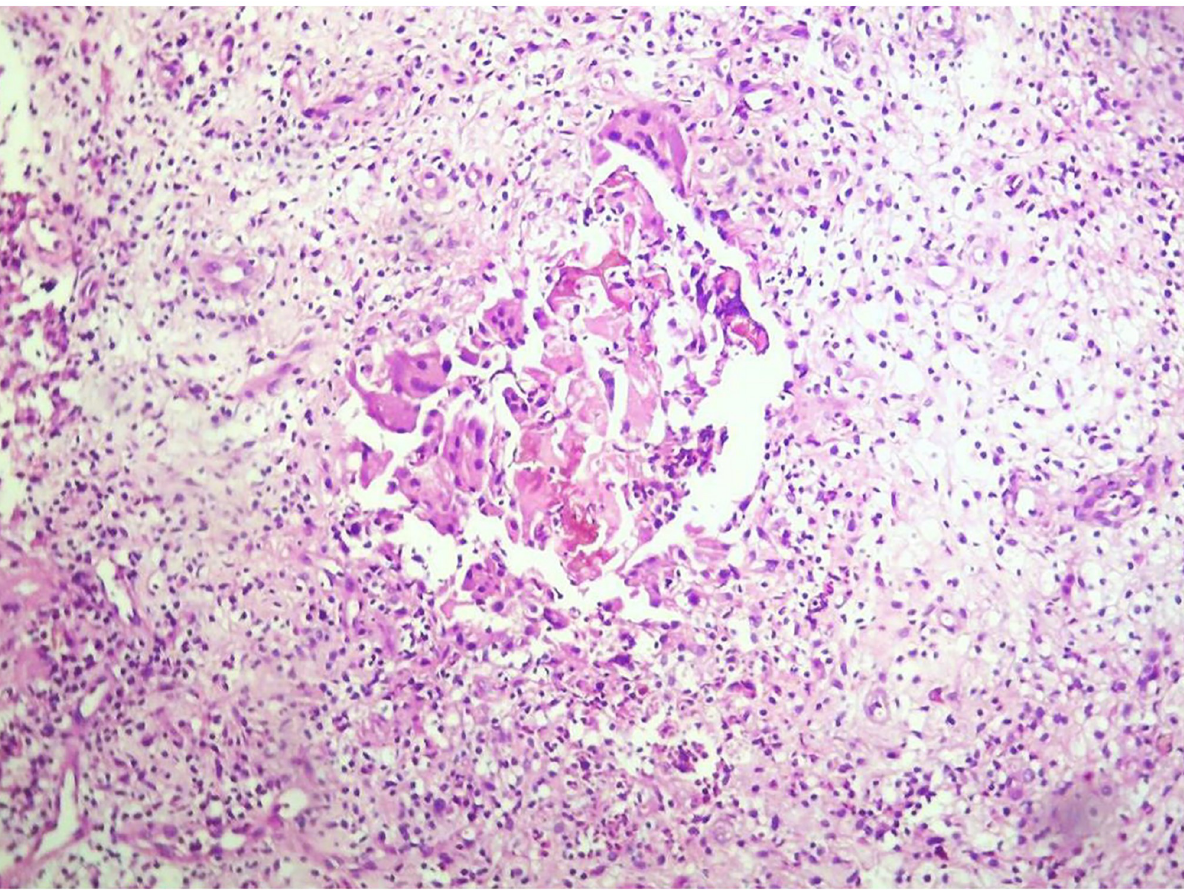
Fig 4. Histopathological section from patient diagnosed as M . mycetomatis based on the culture results; Histopathology report was been negative for fungus and when we retrieved the slide we can see adherence of histiocytes at the center with sparse amount of the grains (H and E, X 10).